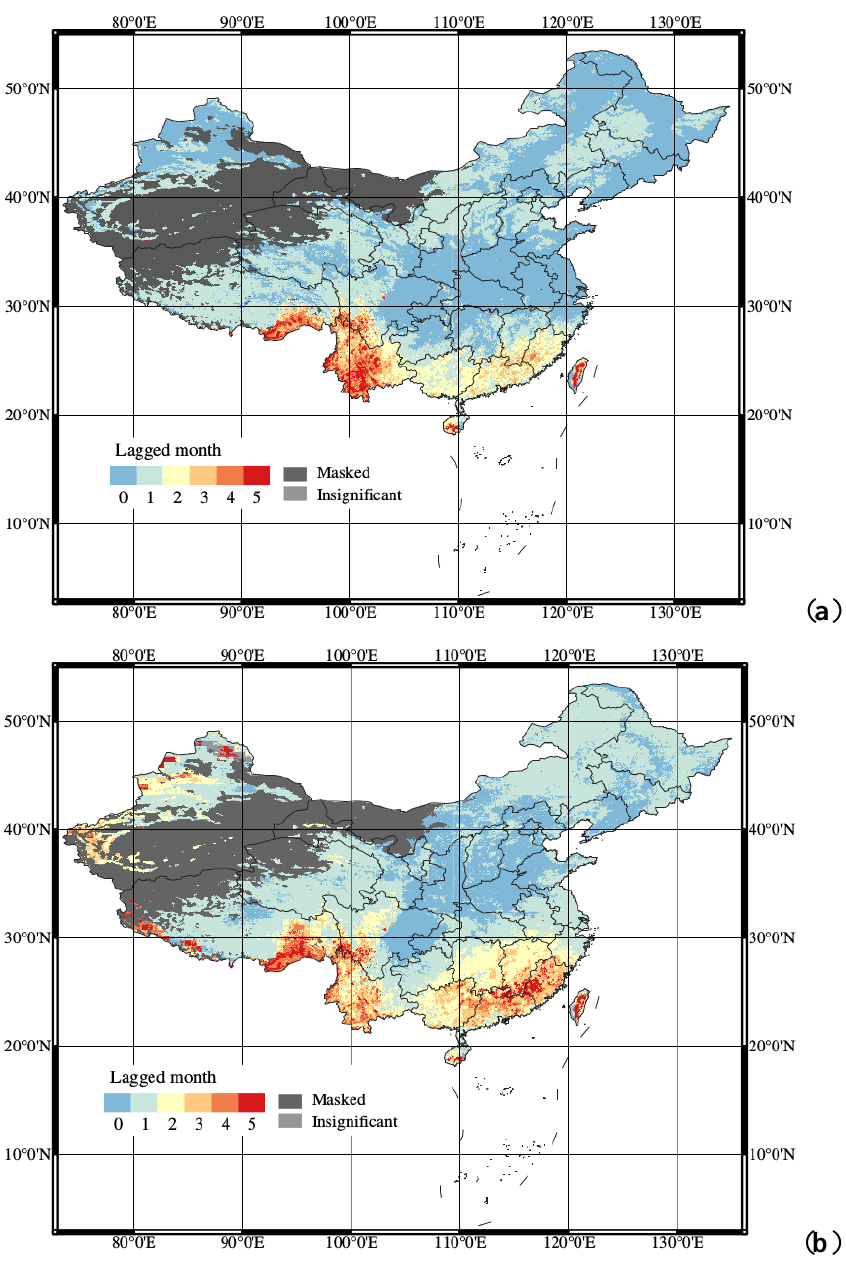
Figure 7. Map of lagged months of ( a ) temperature and ( b ) precipitation. White area represents pixels with no data, light gray pixels represent insignificant trends, and dark gray pixels are masked with threshold of 30-year mean NDVI <